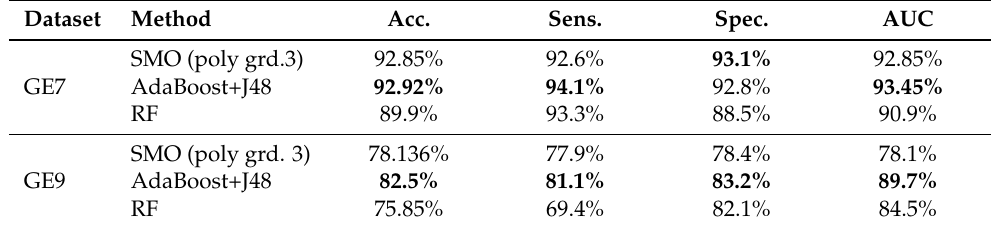
Table 5. Results obtained on the set of relevant textural features through conventional